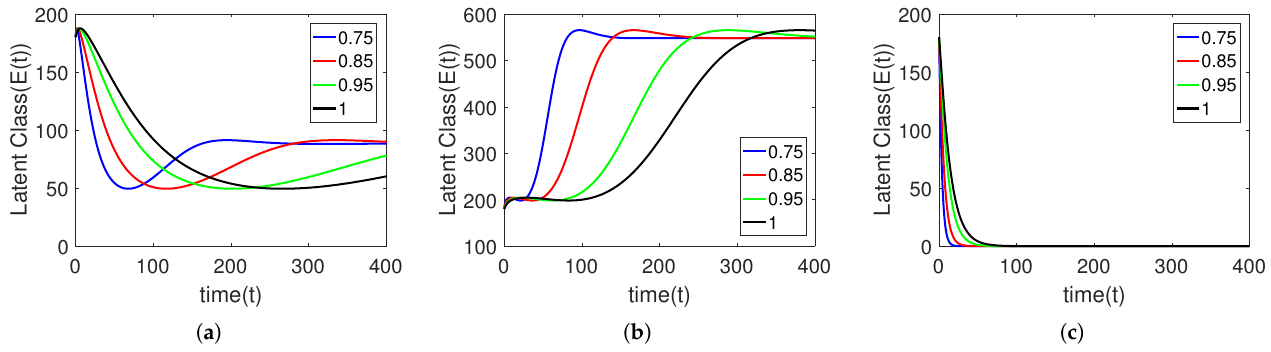
Figure 8. Graphical view ( a – c ) of Latent class on different arbitrary orders γ = 0.75,0.85,0.95,1 for initial data and time duration for TB model by taking the value of η = 0.0143,0.143,1.143.